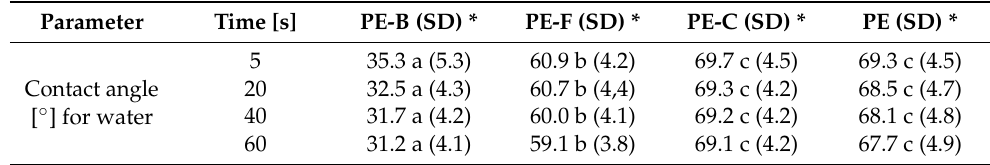
Table 4. Measurement of surface wettability of PE–pomace based